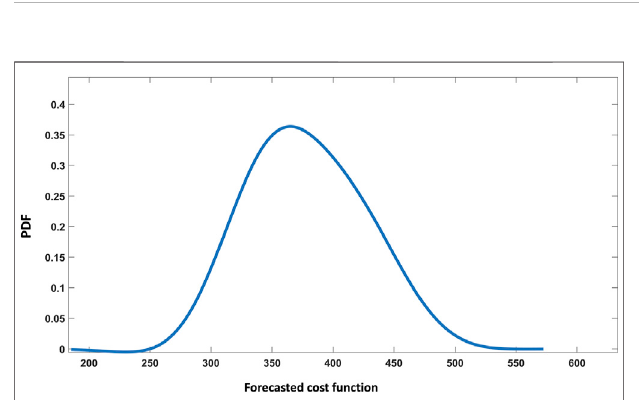
FIGURE 10 | Probability density function (PDF of forecasted cost function based on the AHA for Scenario 2.